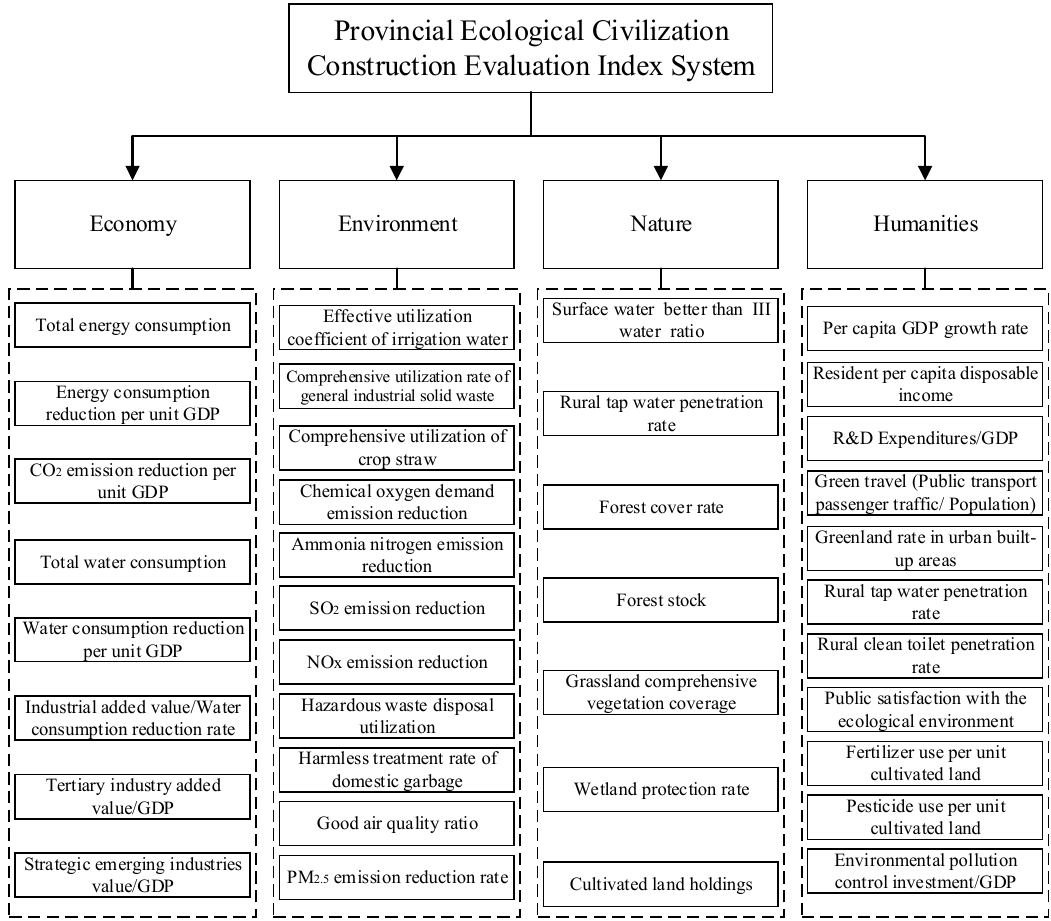
Figure 2. Provincial Ecological Civilization Construction Evaluation Index System.